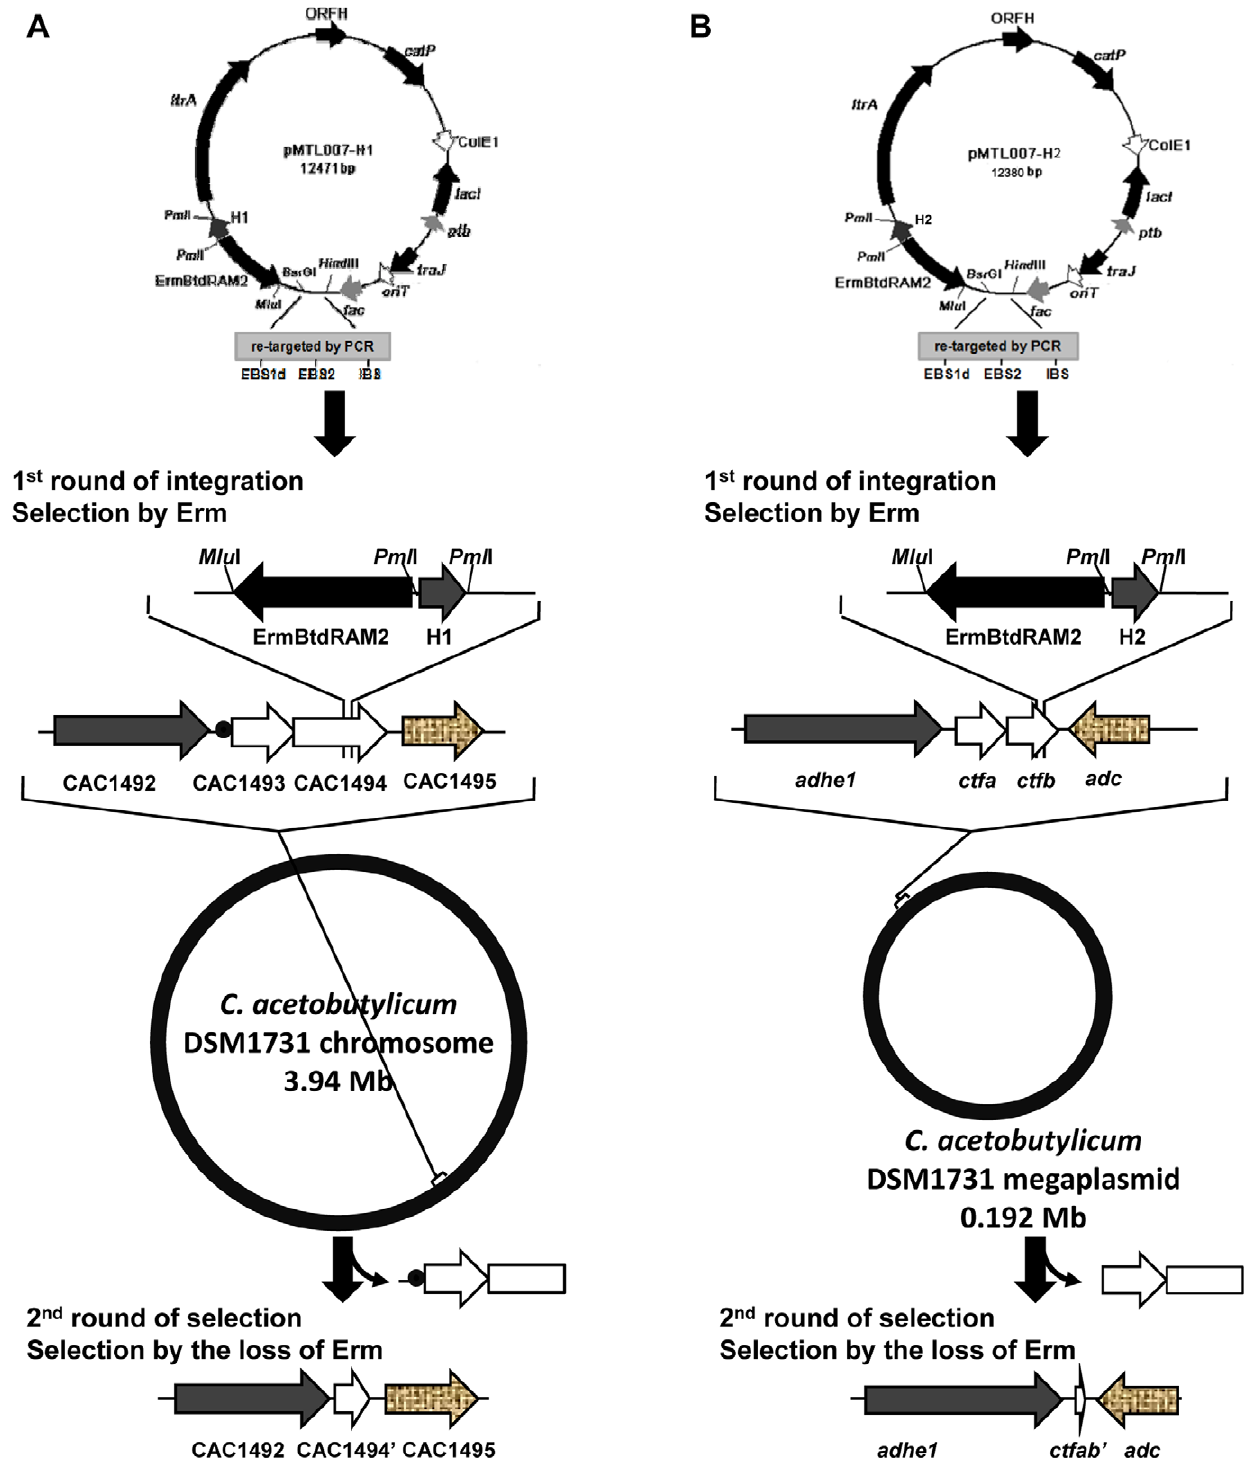
Figure 3. The procedure for deletion of CAC1493-1494 (A) and ctfAB (B) in the genome of C.acetobutylicum .